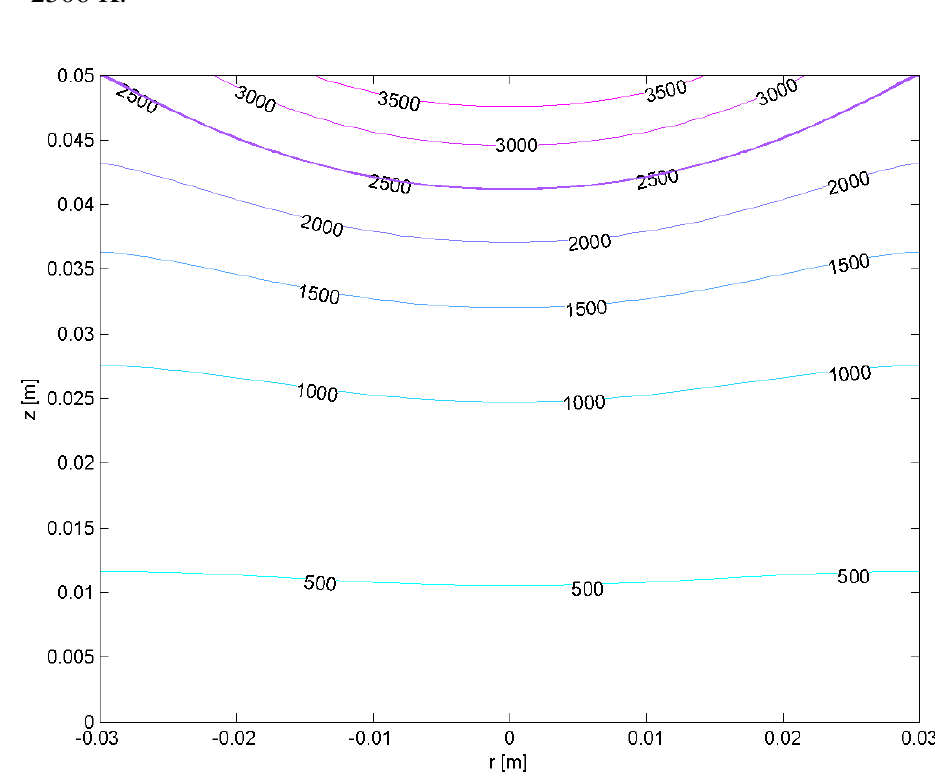
= 18 kW, r = 18 mm, b b